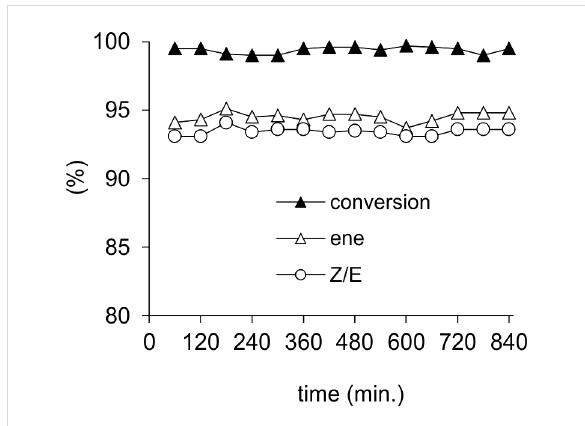
Figure 11: Conversion and selectivity vs time-on-stream for the contin- uous-flow hydrogenation of 11 over Pd@MonoBor catalyst (methanol